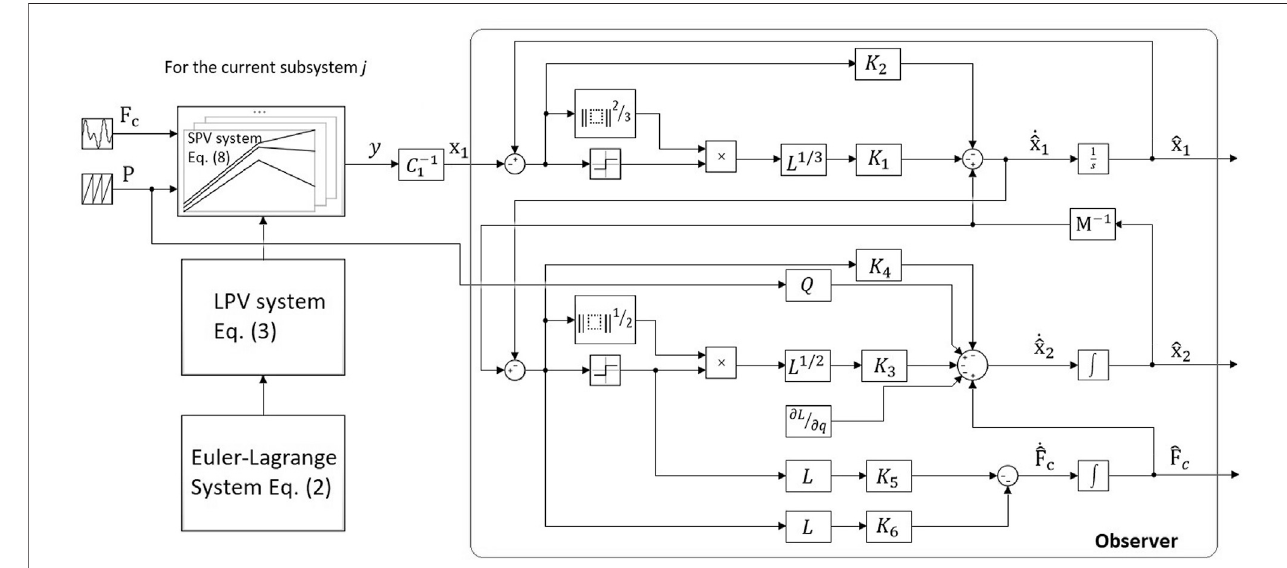
FIGURE 5 | Block diagram of the observer.